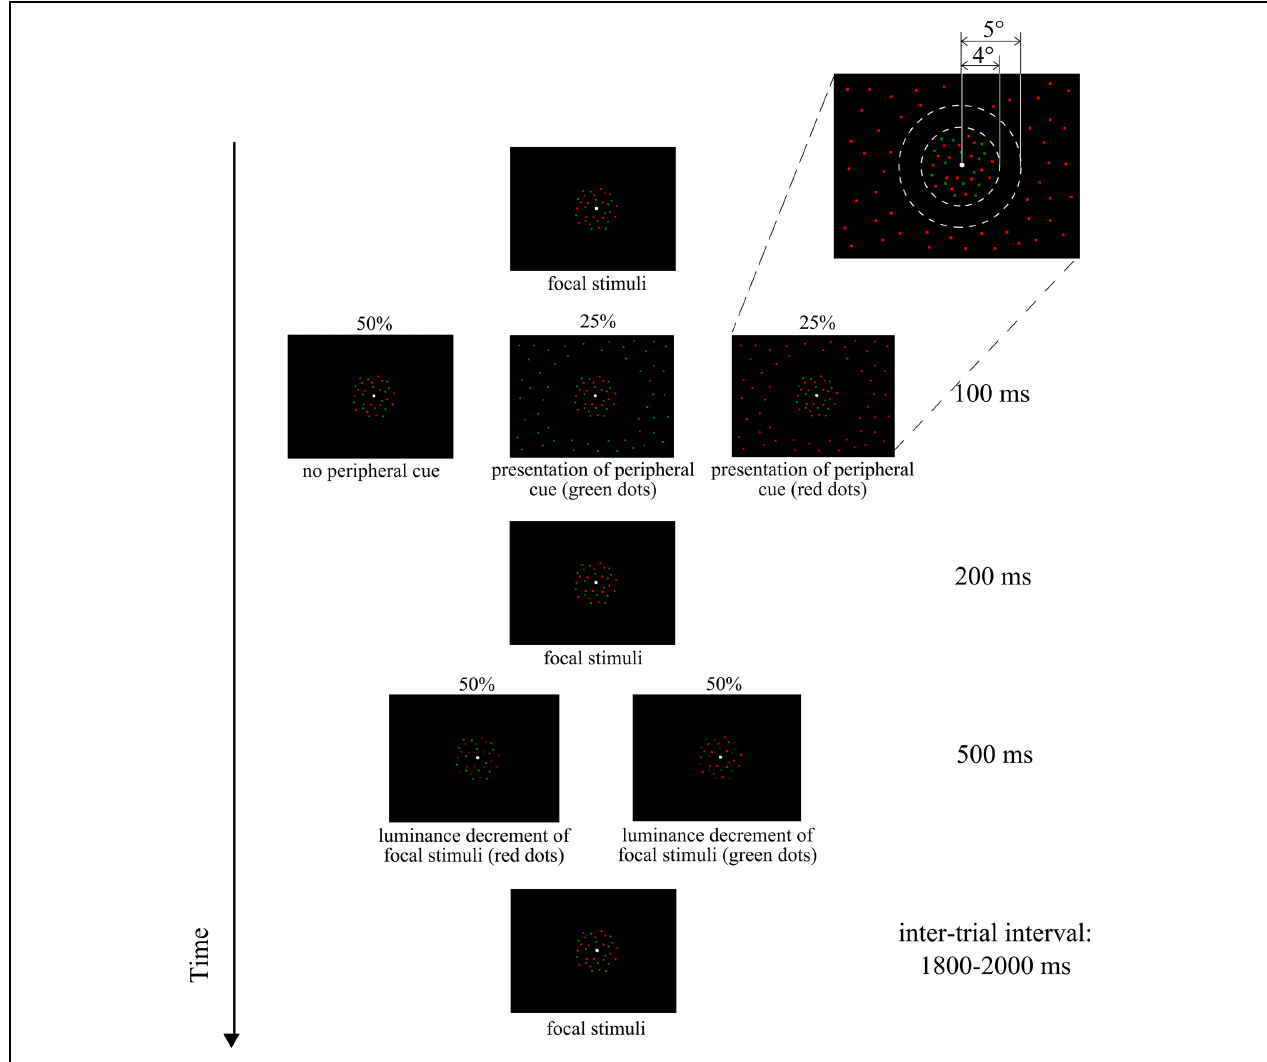
FIGURE 1 | Illustration of the stimulus and the timing of one trial.